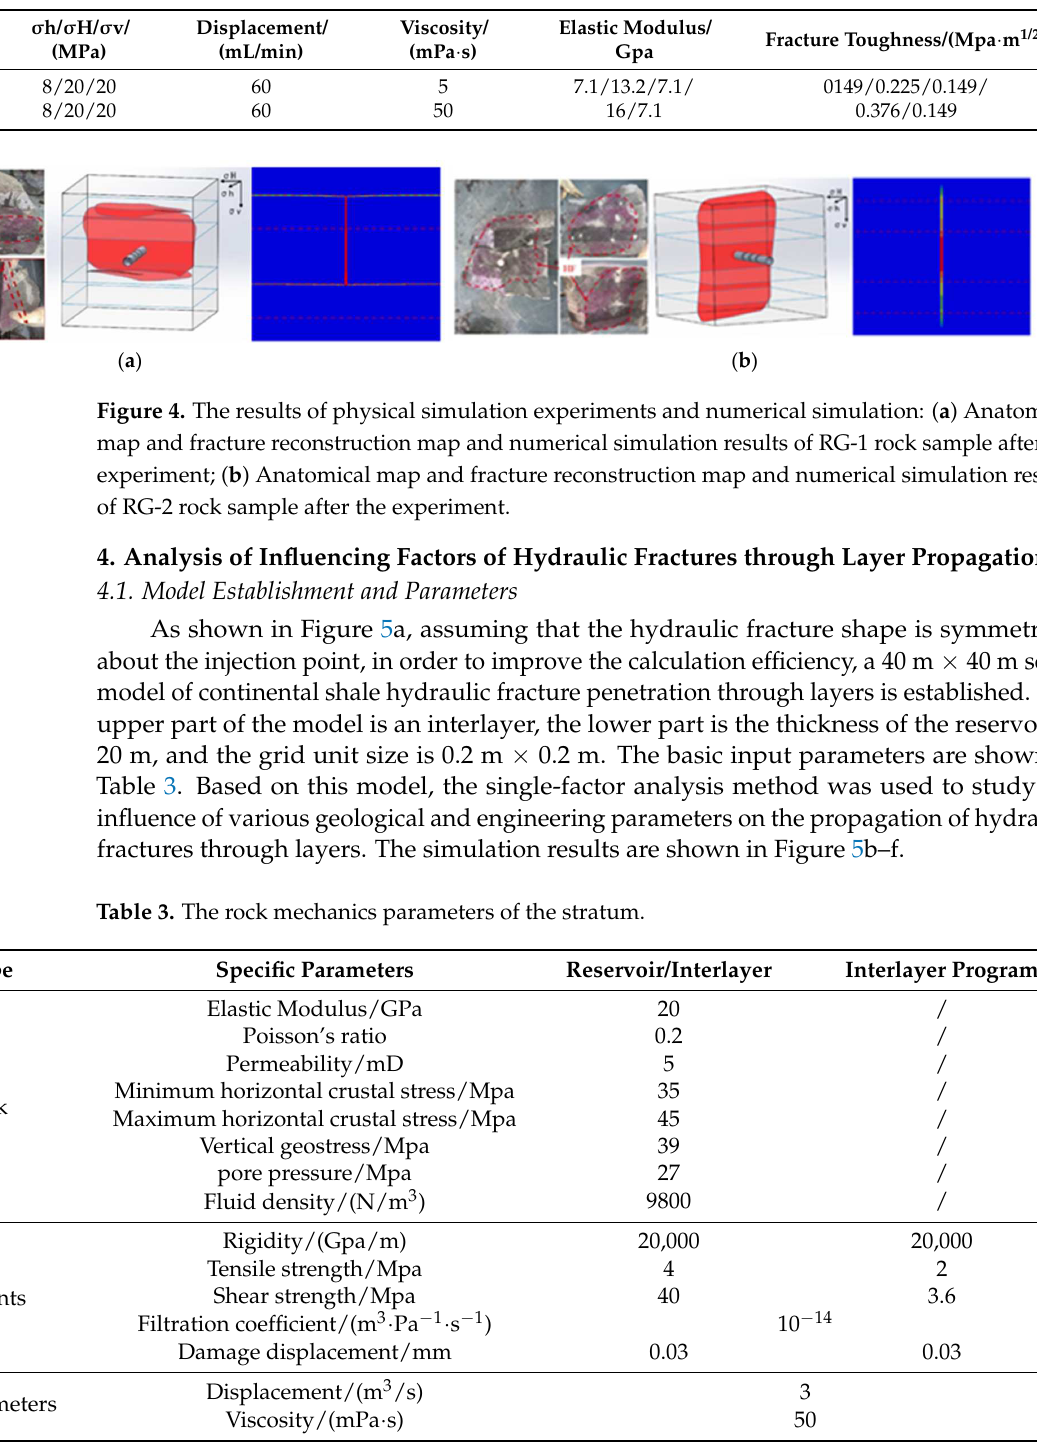
Table 2. Laboratory experimental parameters [20].